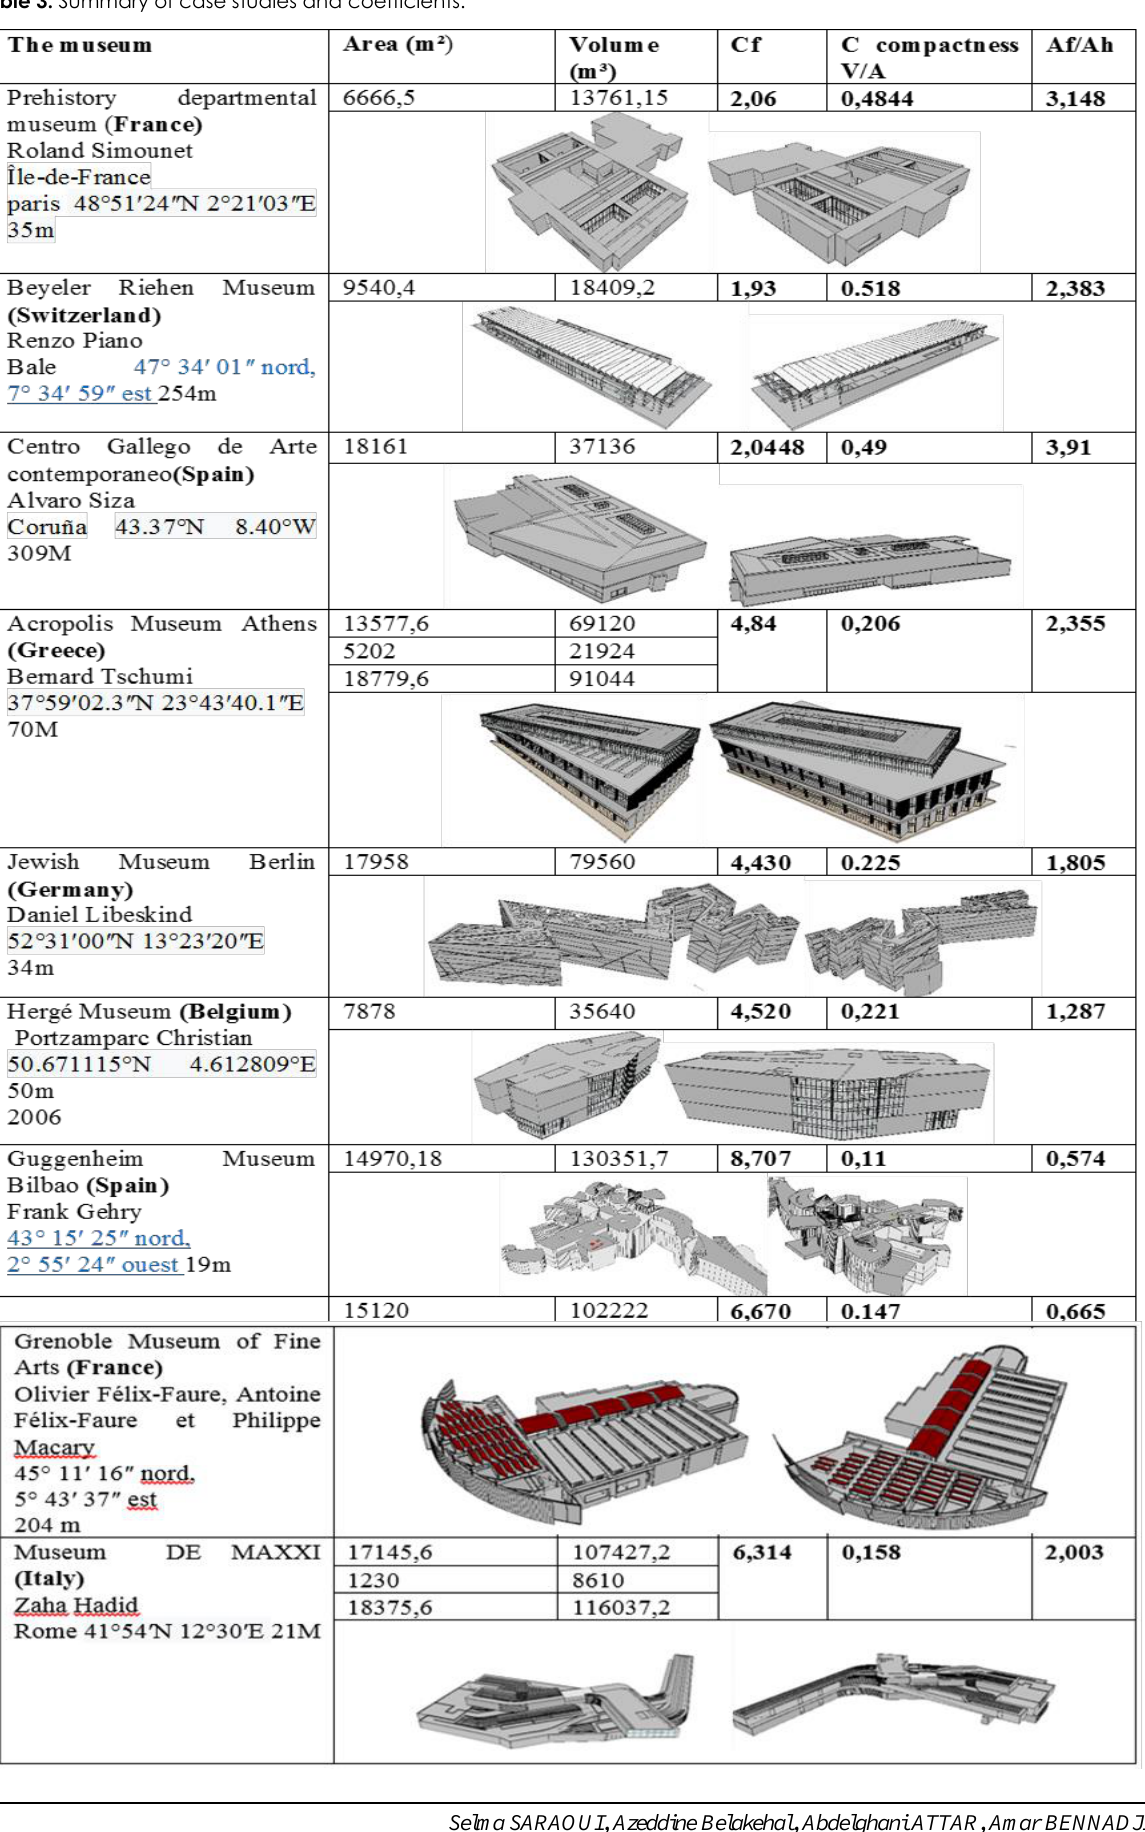
Table 3. Summary of case studies and